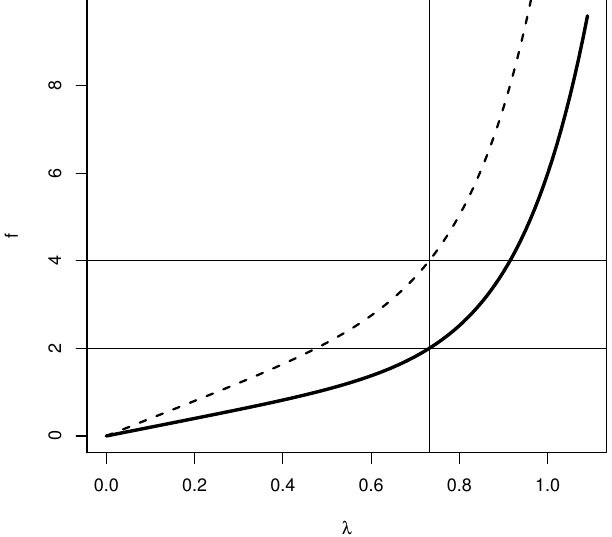
Figure 2. Values of f ( (cid:101) A ) (solid line) and f ( (cid:101) B ) (dotted line) for different values of λ